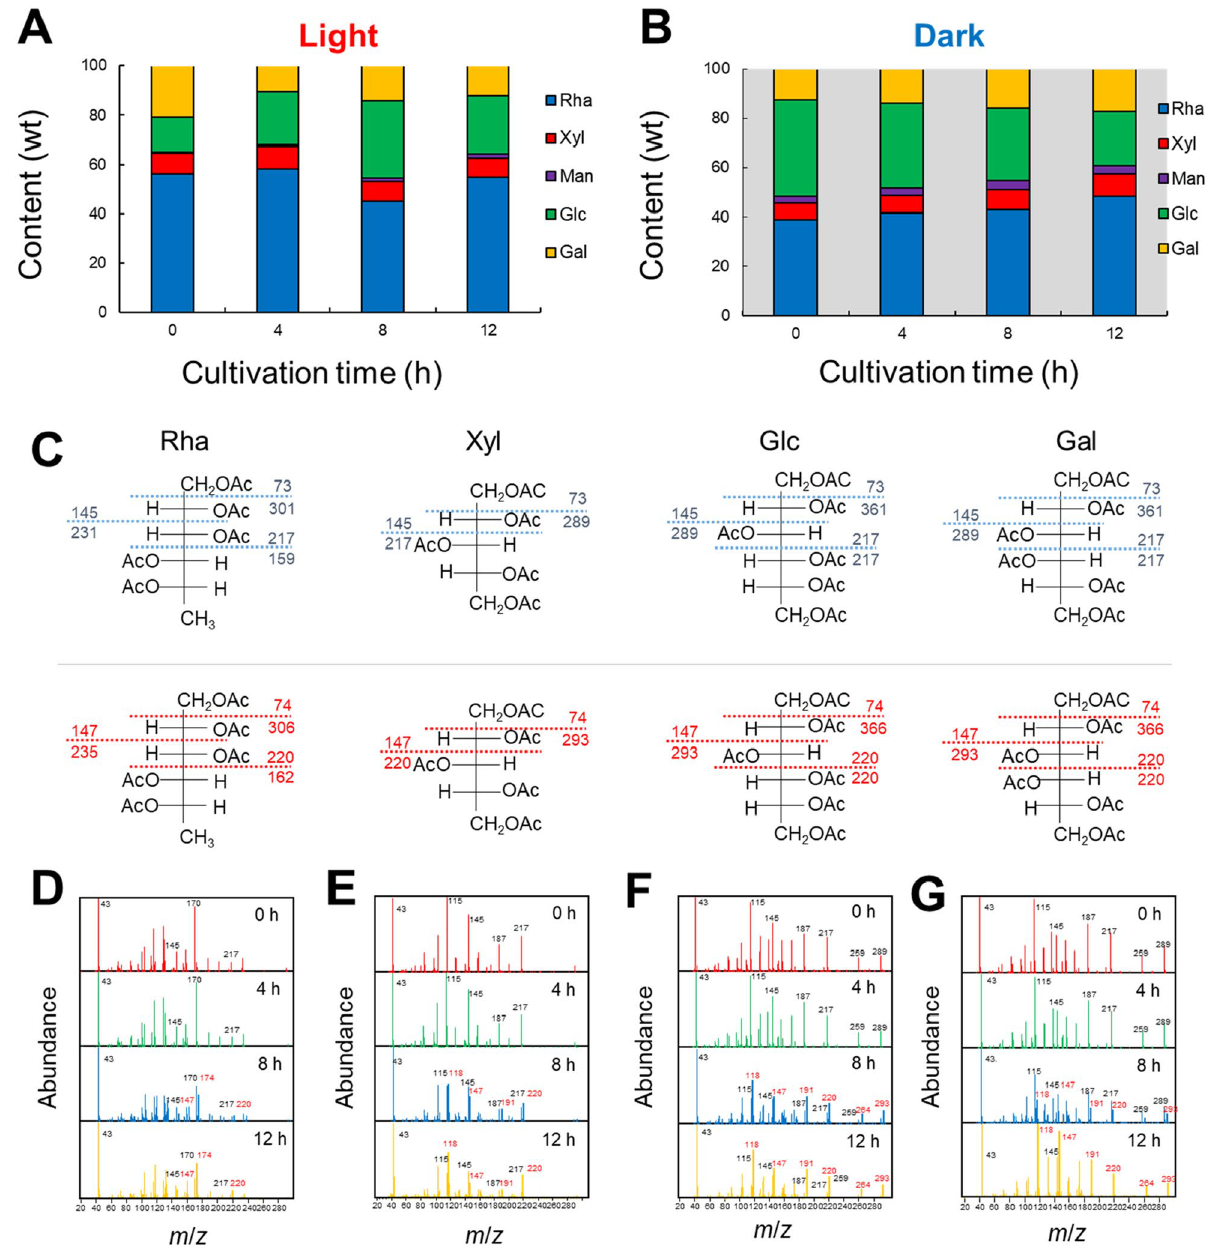
Figure 4. EI-MS spectra of alditol acetate derivatives of neutral sugars obtained by hydrolysis of ulvan extracted from U. meridionalis cultivated under light. Monosaccharide composition of hot-water extracts obtained under ( A ) light and ( B ) dark periods. ( C ) Fragmentation patterns of alditol acetate derivatives of neutral sugars with and without 13 C-labelling. EI-MS spectra of ( D ) rhamnose, ( E ) xylose, ( F ) glucose, and ( G )